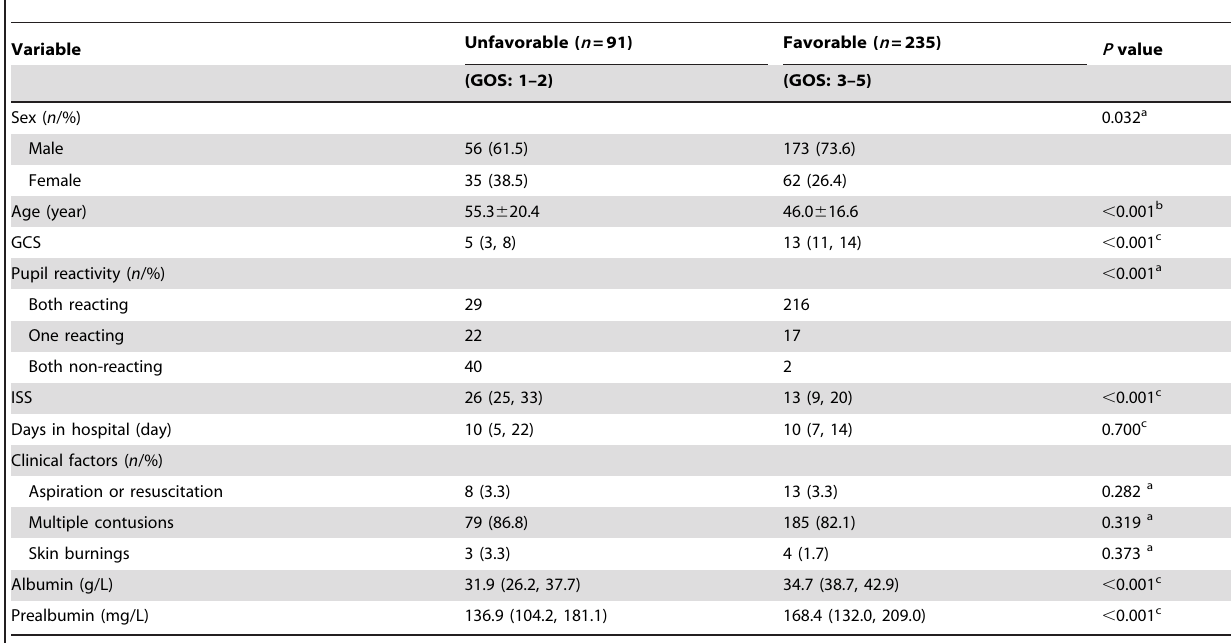
Table 1. Demographic and clinical characteristics in unfavorable and favorable